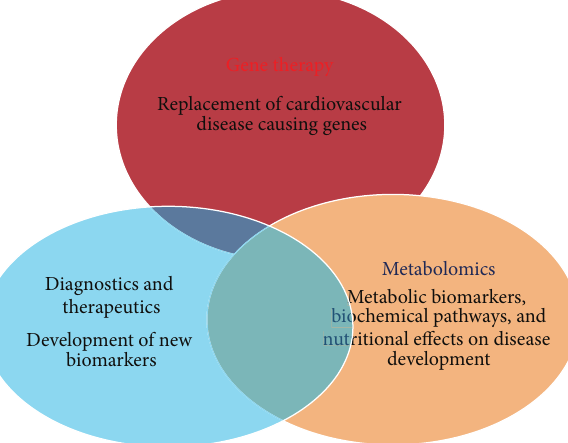
Figure 5: Showing essentiality for integration of diagnostics, therapeutics, metabolomics, and gene therapy for most possible treatment of cardiovascular